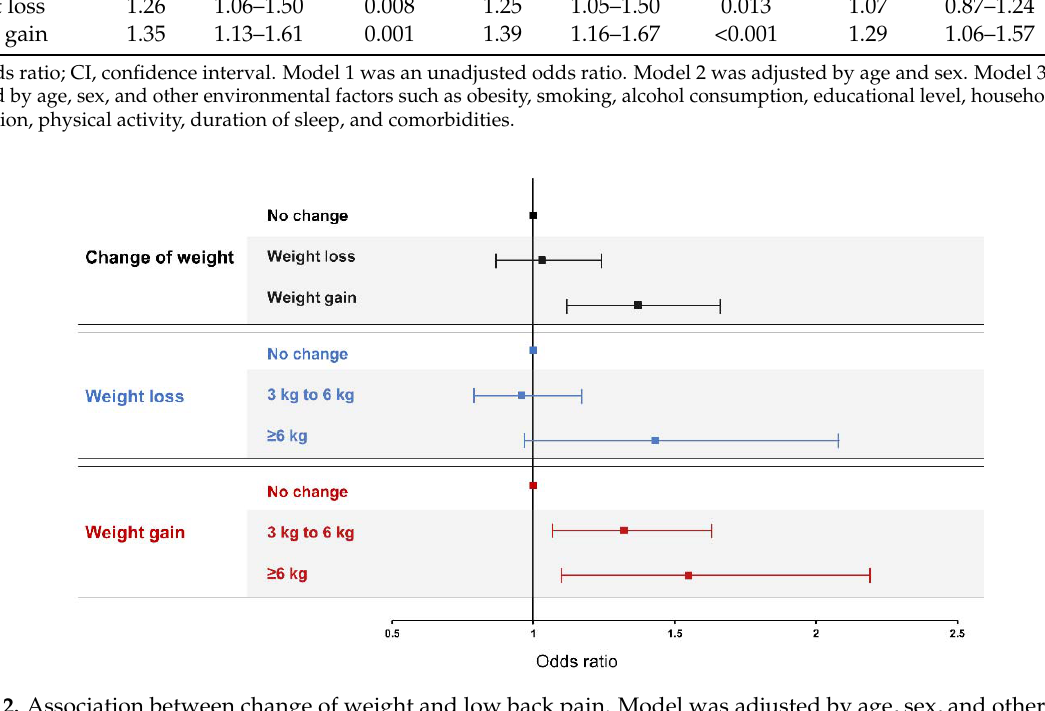
Figure 2. Association between change of weight and low back pain. Model was adjusted by age, sex, and other environmental factors such as obesity, smoking, alcohol consumption, educational level, household income, occupation, physical activity, duration of sleep, and comorbidities.